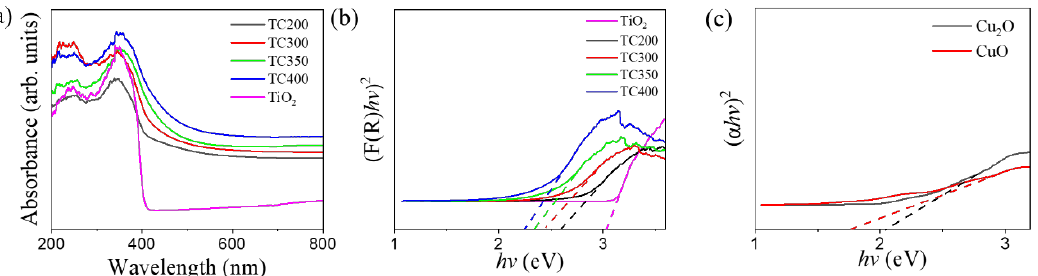
Figure 8. ( a ) Absorption spectra of various samples and Band-gap evaluations of ( b ) various nanorod samples, ( c ) pristine Cu 2 O and CuO